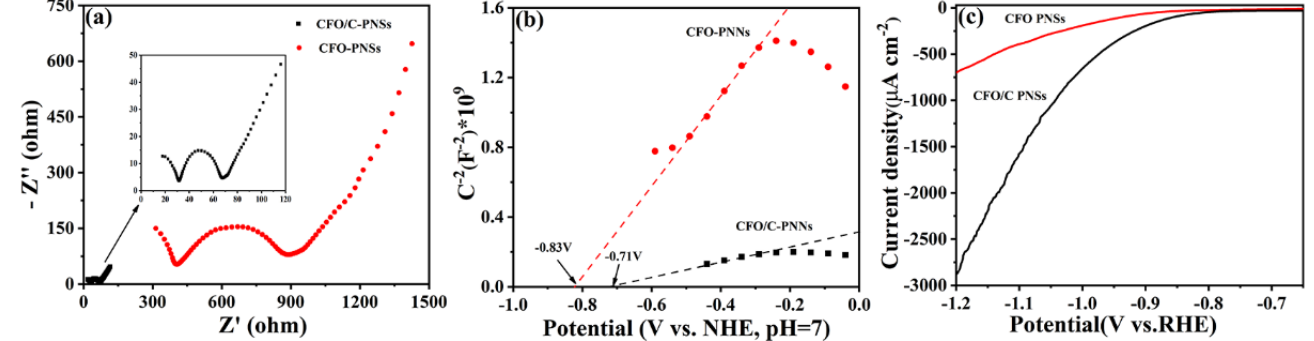
Figure 10. ( a ) Electrochemical impedance spectroscopy (EIS); ( b ) Mott – Schottky curves (M – S); ( c ) linear sweep voltammetry curve (LSV).